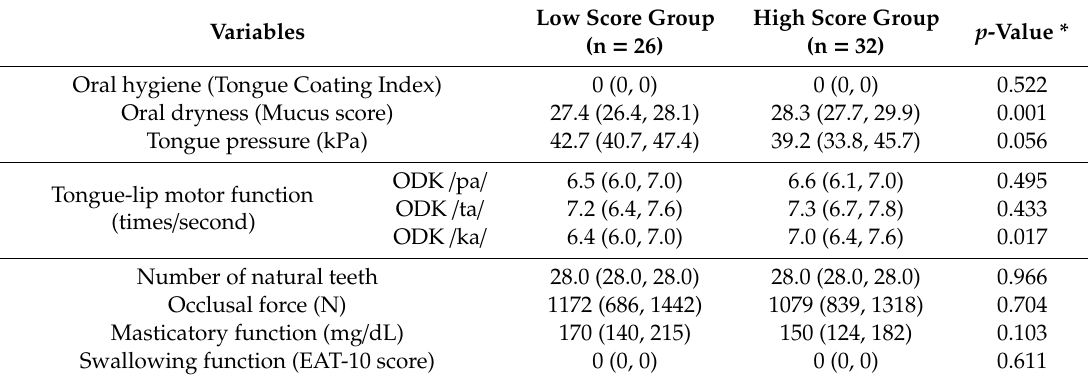
Table 3. Comparison of oral function in the two groups based on the GOHAI score.